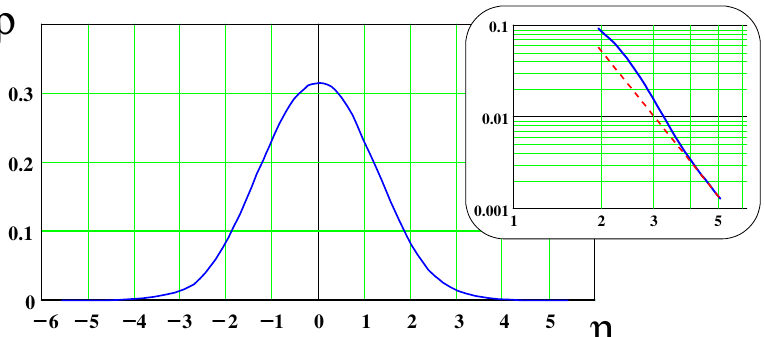
Figure 3. The normalized distribution (see Equation (49)) of the reduced angle η = θ ( l / x ) 1/3 in the proximal aligned layer, where θ is the angle of a chain segment and x is its distance to the membrane. Inset: The same function in the log-log scale. The dashed line indicates the asymptotic law, ρ ∝ η − 4 for | η | (cid:29) 1 (cf. Equation